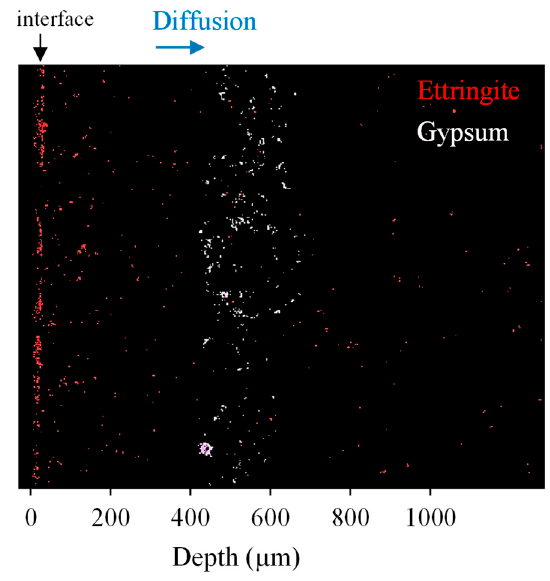
Figure 3. Gypsum and ettringite precipitation detected using the spectrum given in Figure 1 in the 60-day degraded cement paste.